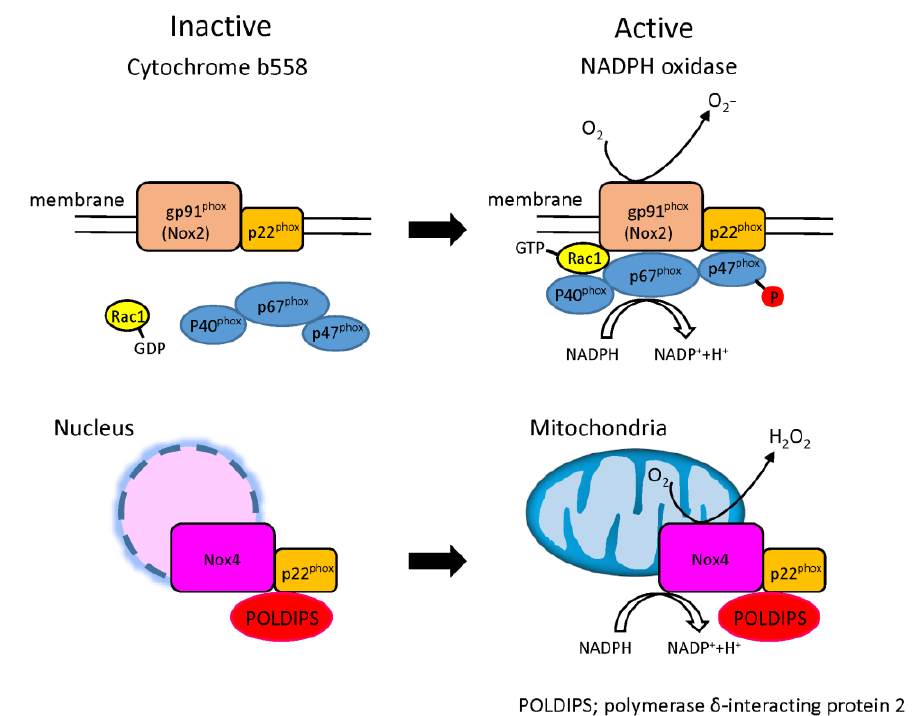
Figure 3. Structure of NADPH oxidase in the heart. NADPH oxidase complex is composed of two major components. Plasma membrane spanning cytochrome b558 composed of p22phox and a Nox subunit (gp91phox (Nox2), Nox4) and cytosolic components